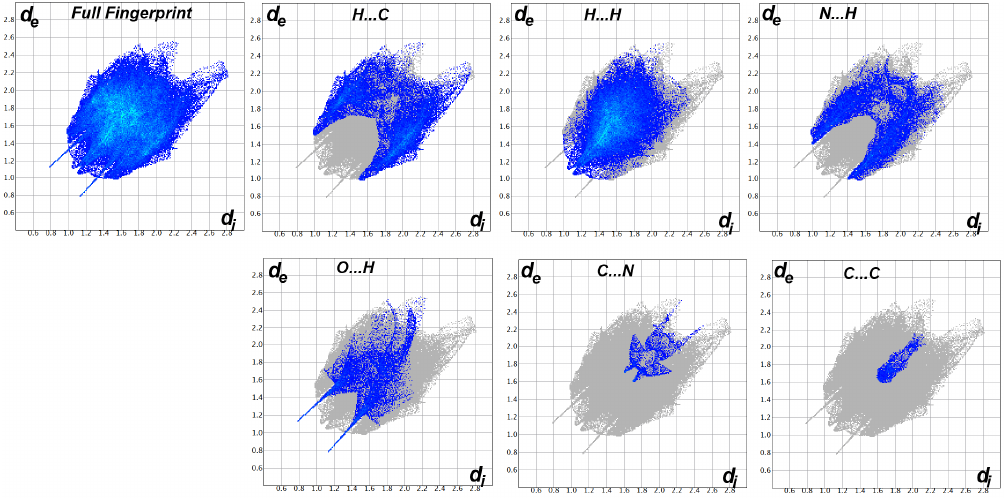
Figure 7. Full and decomposed fingerprint plots for the important interactions in 4